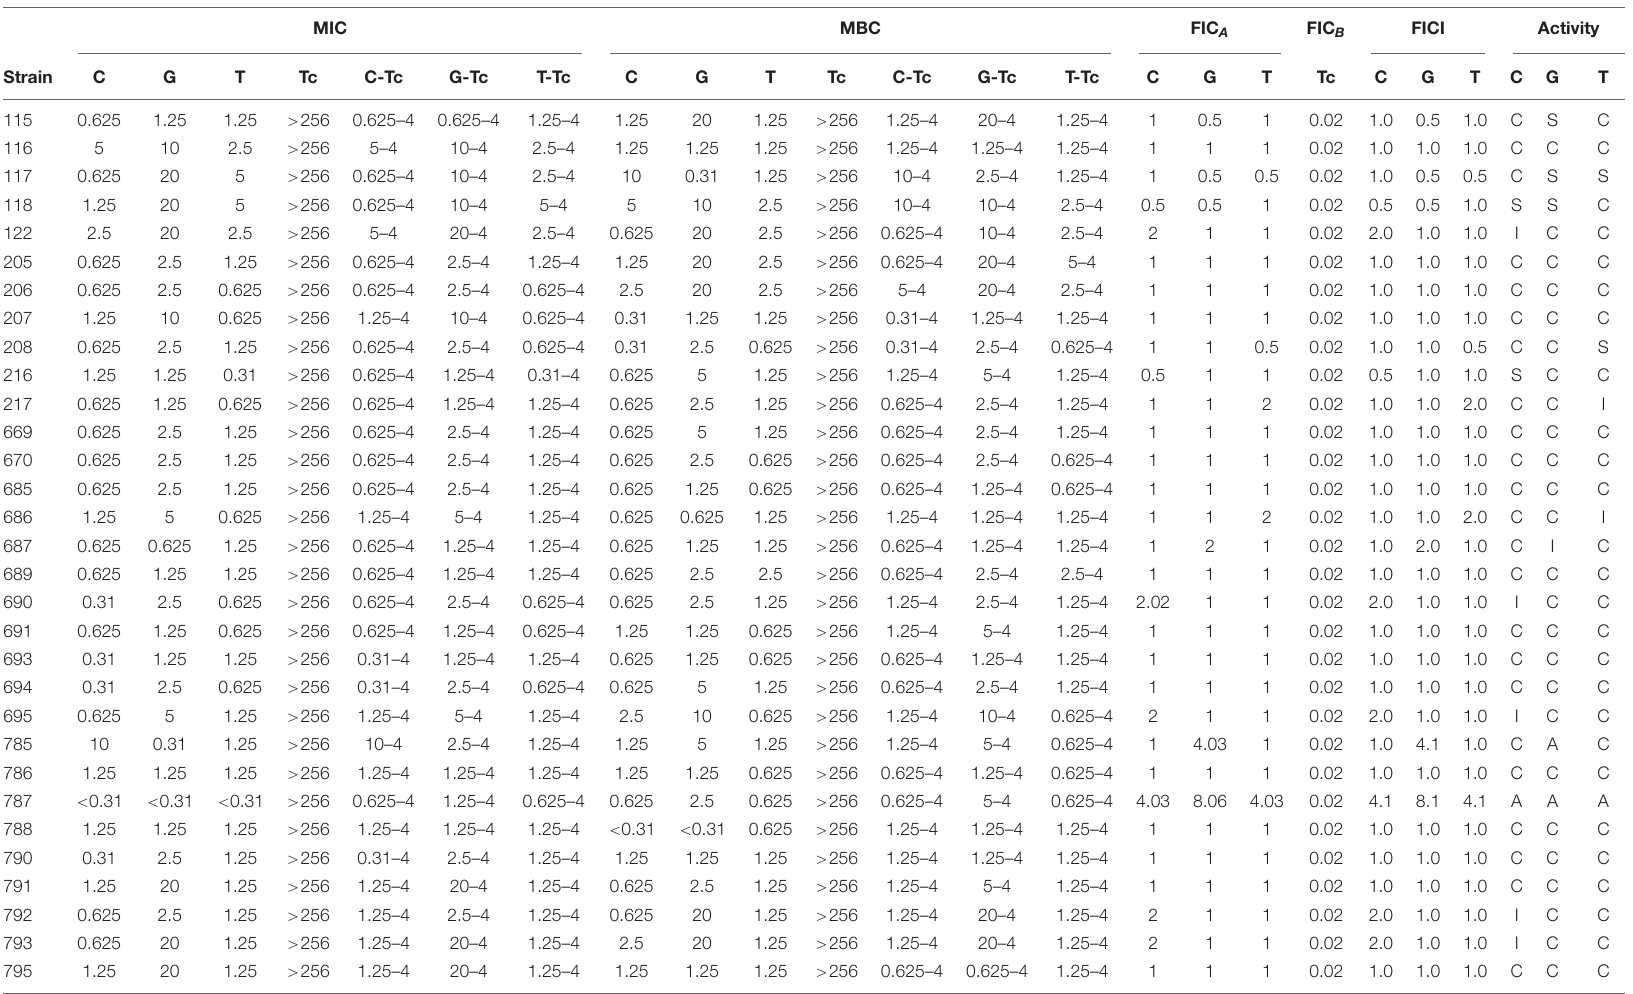
TABLE 3 | Minimum inhibitory concentration (MIC), MBC values, and FIC index of Coridothymus capitatus , Eugenia caryophyllata and Thymus vulgaris EOs alone and in combination with tetracycline against Salmonella strains, determined by broth dilution technique and checkerboard method after 48 h of incubation at 37 ◦ C.